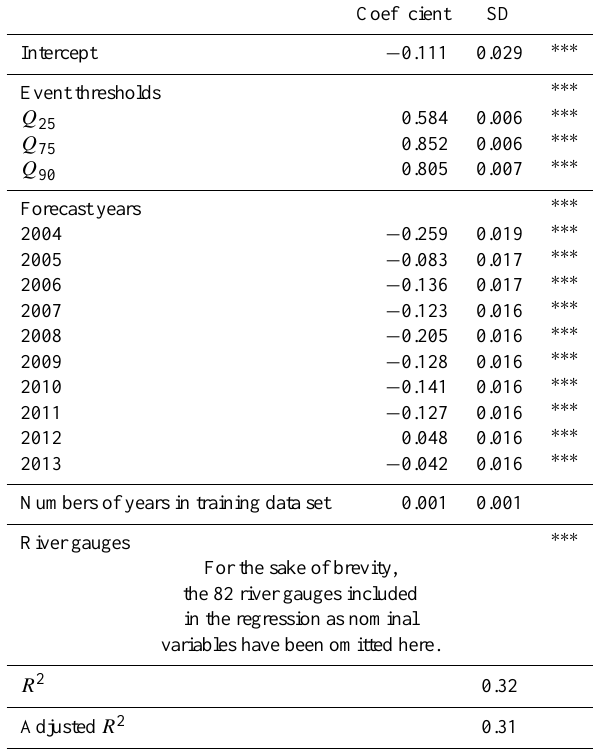
Table 6. Regression results of sensitivity